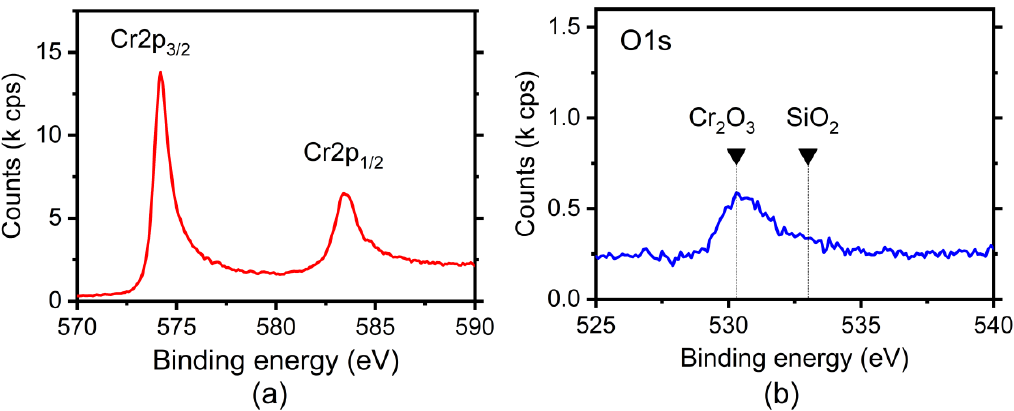
Figure 2. The high-resolution Cr2p ( a ) and O1s ( b ) XPS spectra for Cr ultrathin film.